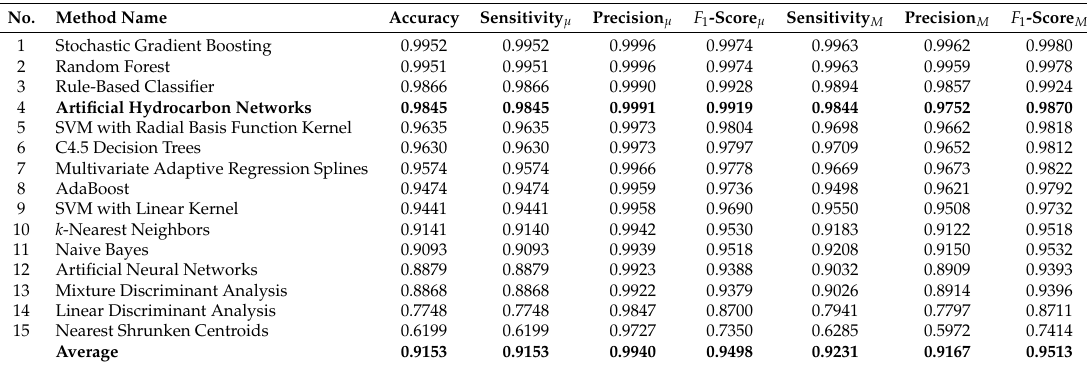
Table 11. Comparison of the supervised classifiers using the first 30 s of each activity carried out by all subjects.